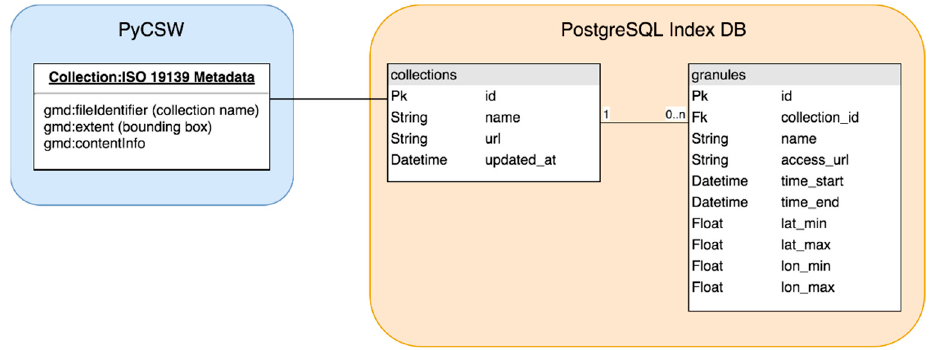
Figure 7. Metadata collection and granule resources stored in referentially linked PyCSW and PostgreSQL databases. PyCSW gmd: fileIdentifier corresponds as a key to collections table name field in the SQL database.